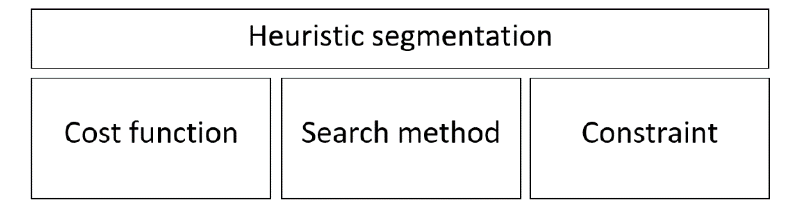
Figure 5. Overview of heuristic segmentation approach by ruptures based on